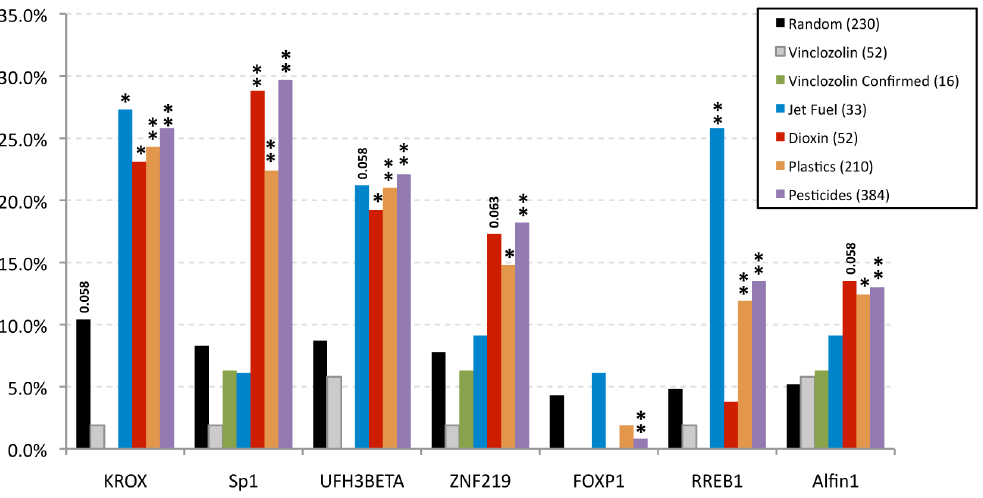
Figure 4. Incidence of consensus motifs of known transcription factor binding sites in DMR from a variety of F3 generation exposure lineage sperm DNA. Columns with (**) represent significant change with p , 0.01, while columns with (*) represent significant change with p , 0.05. For nearly significant changes p-values are shown in the respective column. Colored legend for specific exposure lineage DMR sets with total number indicated. The percentage incidence is indicated for the different transition factor sites.